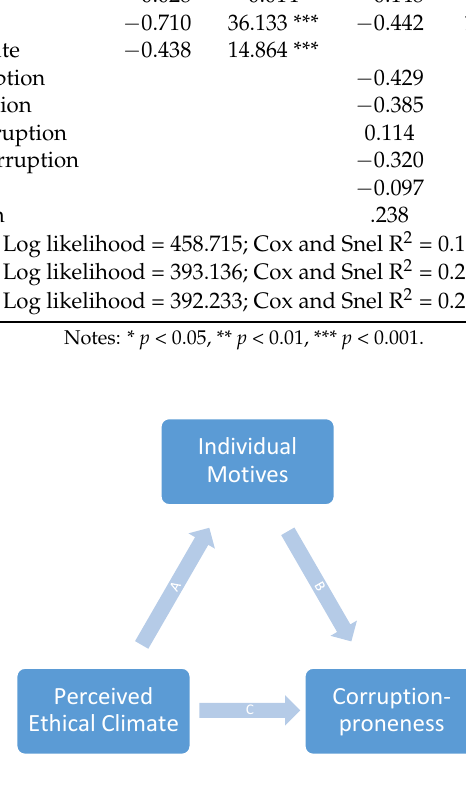
Table 4. Results of the mediation analyses ( n = 523). a × b